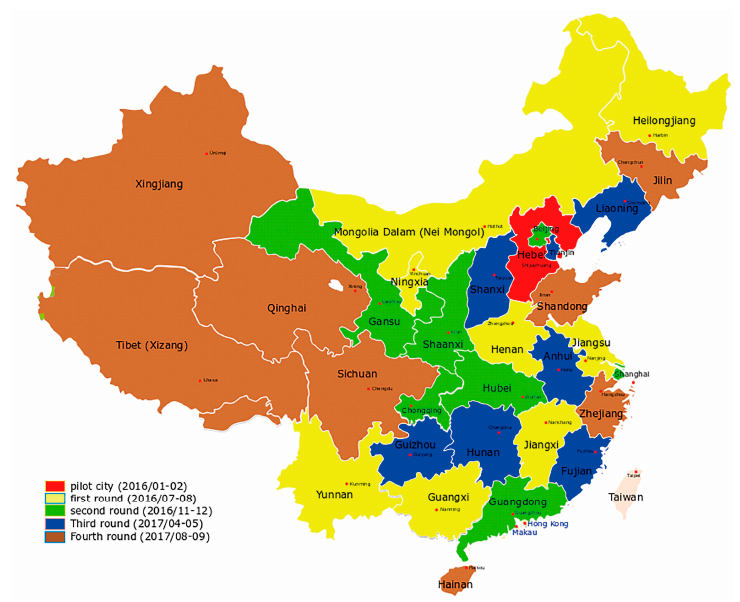
Figure 2. The Central Environmental Protection Inspectorate achieved full coverage in 31 districts in batches.